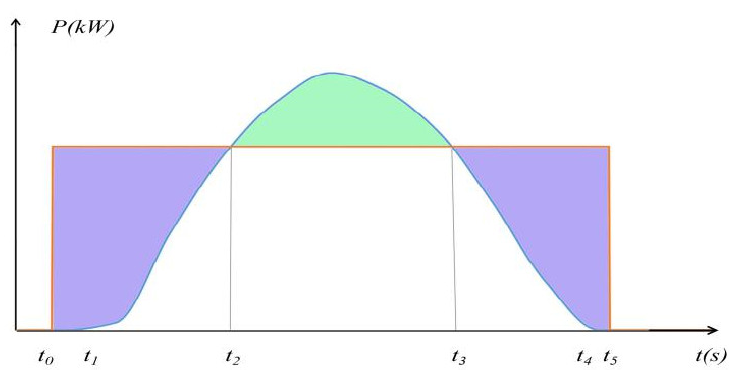
Figure 4. Schematic diagram of energy storage configuration.